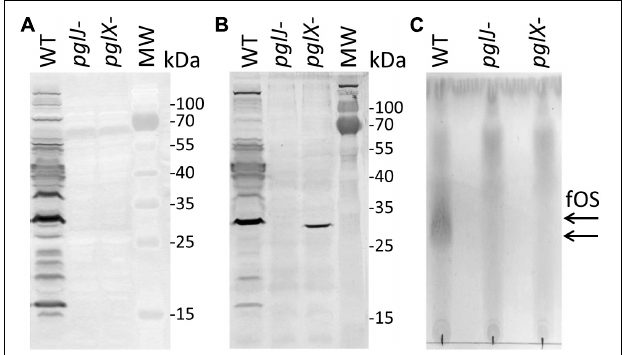
FIGURE 3 | Product analysis of Cf WT, pglX- and pglJ- strains. (A) Western blot of whole-cell lysates with Cff- N-glycan-specific antiserum, and (B) wheat germ agglutinin reactivity of whole cell lysates of the WT, pglJ -, and pglX- strains. (C) Thin-layer chromatography (TLC)-free oligosaccharide (fOS) analysis of WT, pglJ -, and pglX- strains. Molecular weight (MW) markers for the western blots (in kDa) are indicated on the right; arrows indicate the migration of WT fOS on the TLC